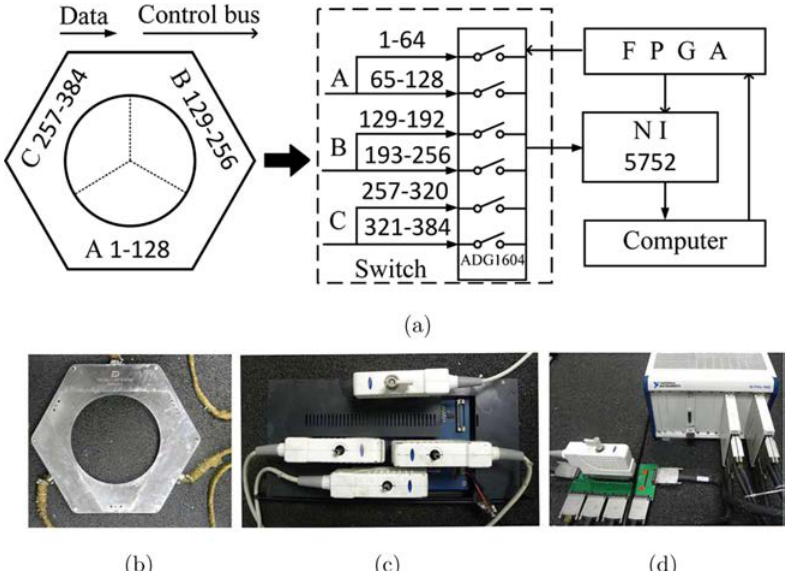
Fig. 10. (a) The process of signal acquisition of multi-element TAI system. (b) Photographs of the full ring transducer. (c) The 384-64 element switch system. (d) The 64-element data acquisition system.